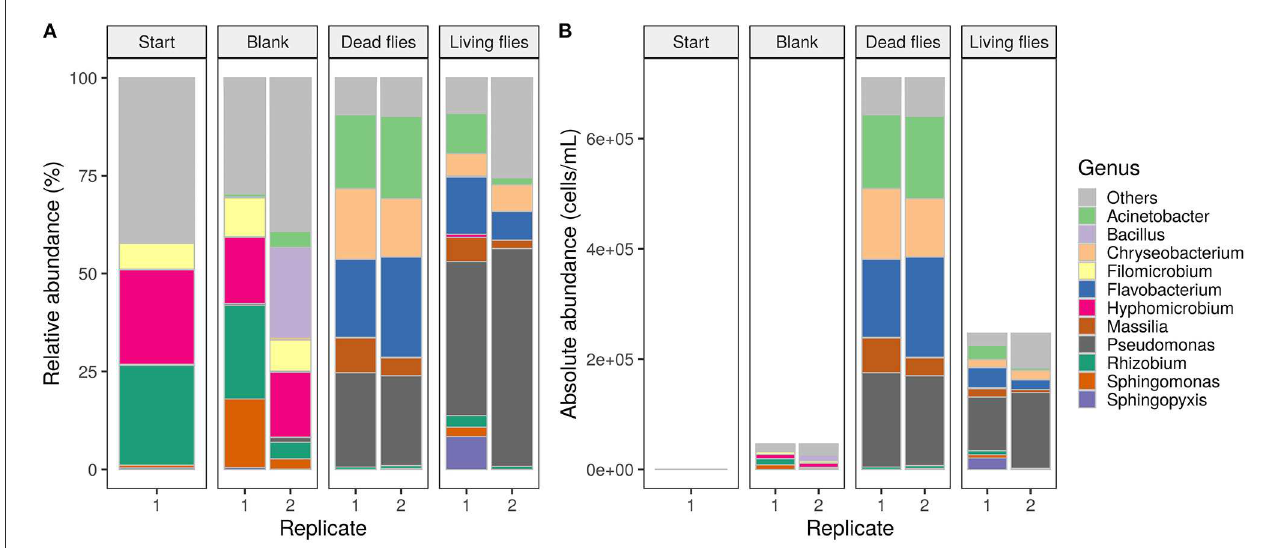
FIGURE5 (A) Relative and (B) absolute abundances of the 25 most abundant genera at the start and end of the experiment. The bacterial composition of start and blank conditions were similar. New genera were introduced when flies were added to the water samples.